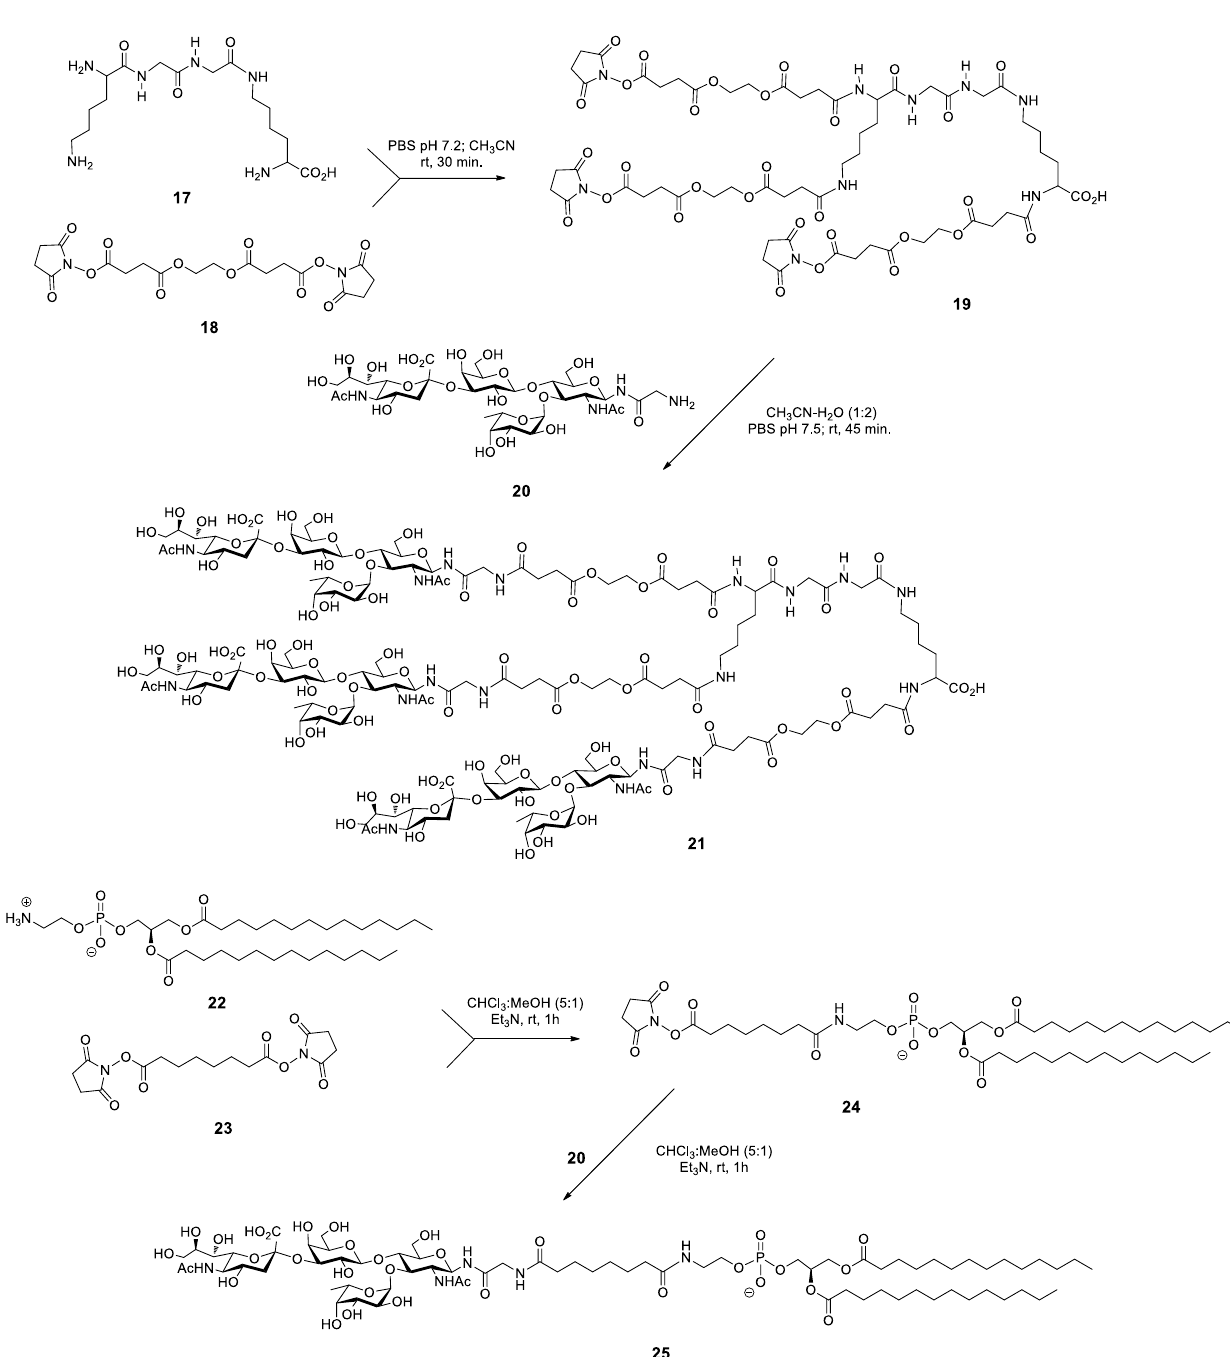
Scheme 4. Detailed synthesis of mono- ( 20 ), dimeric- (not shown), and trimeric ( 21 ) glycodendrons of the biologically relevant sialyl Lewis X (sLe X ) antigen and comparison to its corresponding neoglycolipid analog 25 [33].